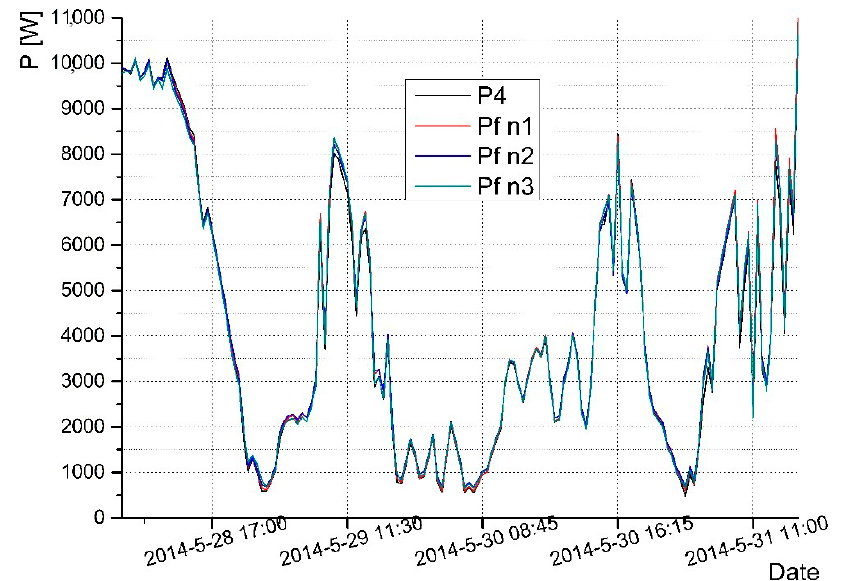
Figure 10. Comparative behavior of three ANNs fed with data from PVS1.